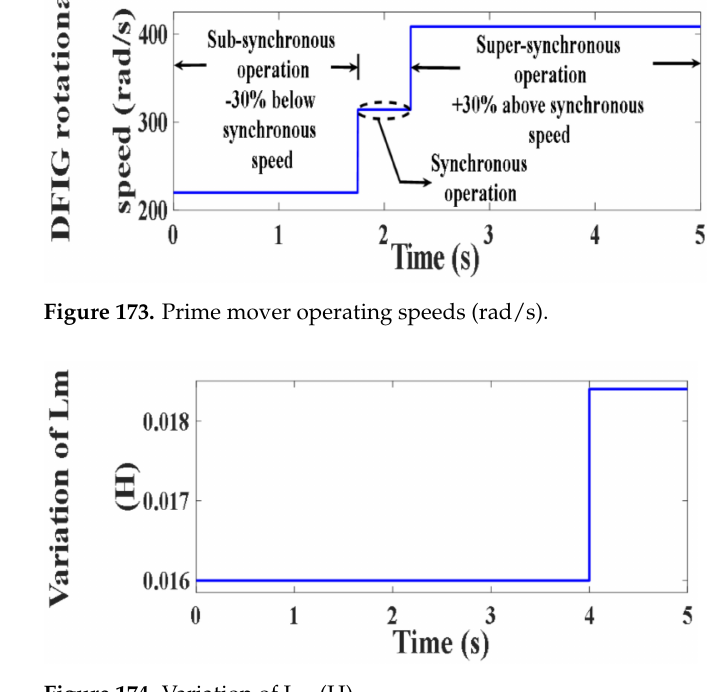
Figure 174. Variation of L m (H).